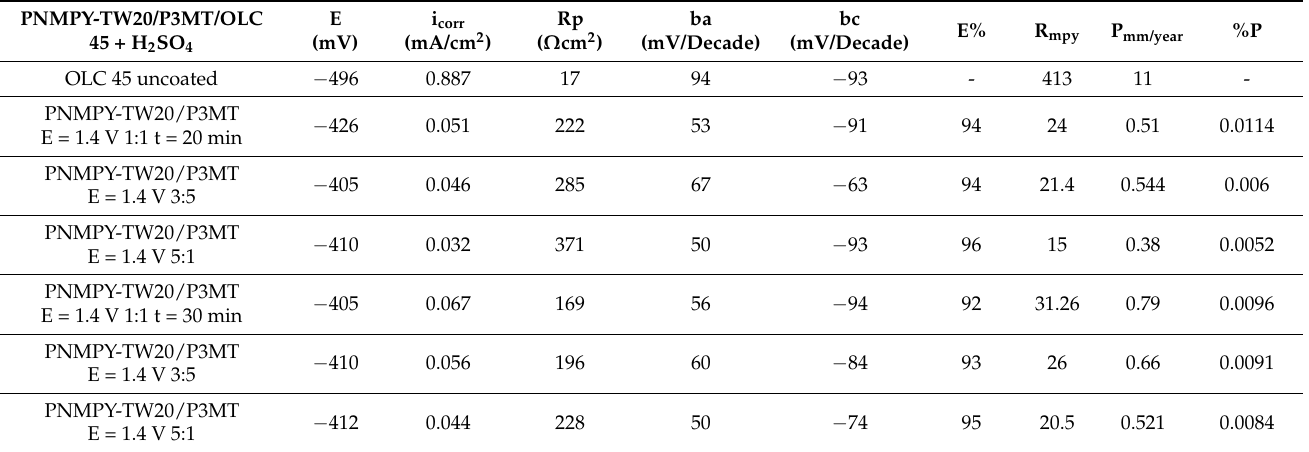
Table 4. Kinetic corrosion parameters of coated and uncoated OLC 45 sample in 0.5 M H 2 SO 4 solution at 25 ◦ C.